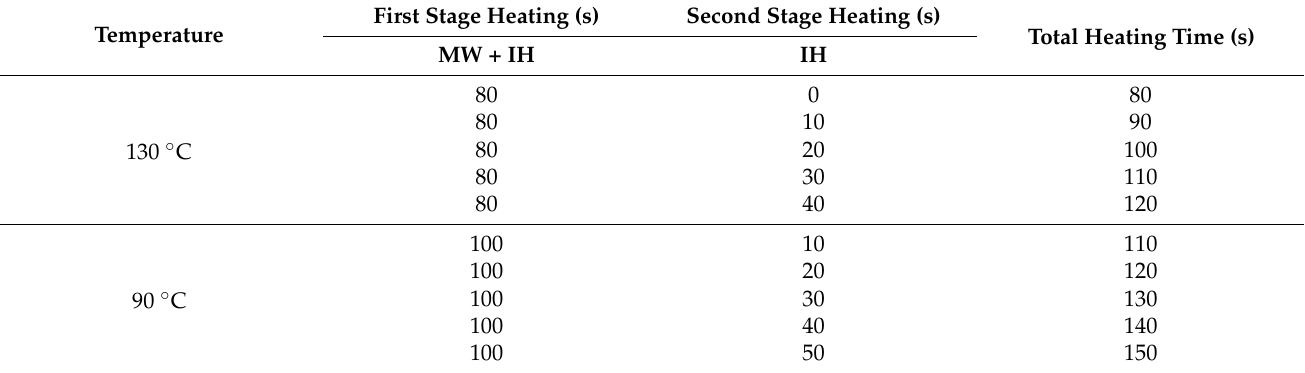
Total Heating Time (s)